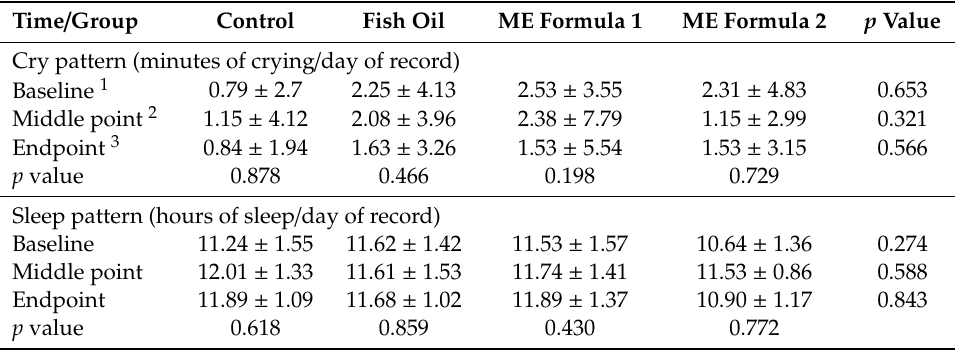
Table 7. Total minutes of cry and total hours of sleep by di ff erent